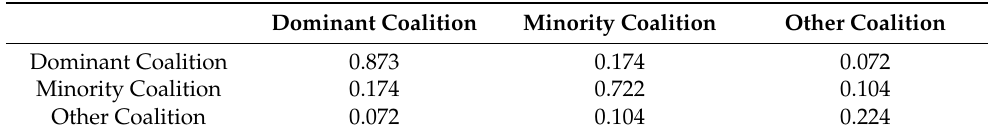
Table 1. Network factions density matrix (2004–2009).